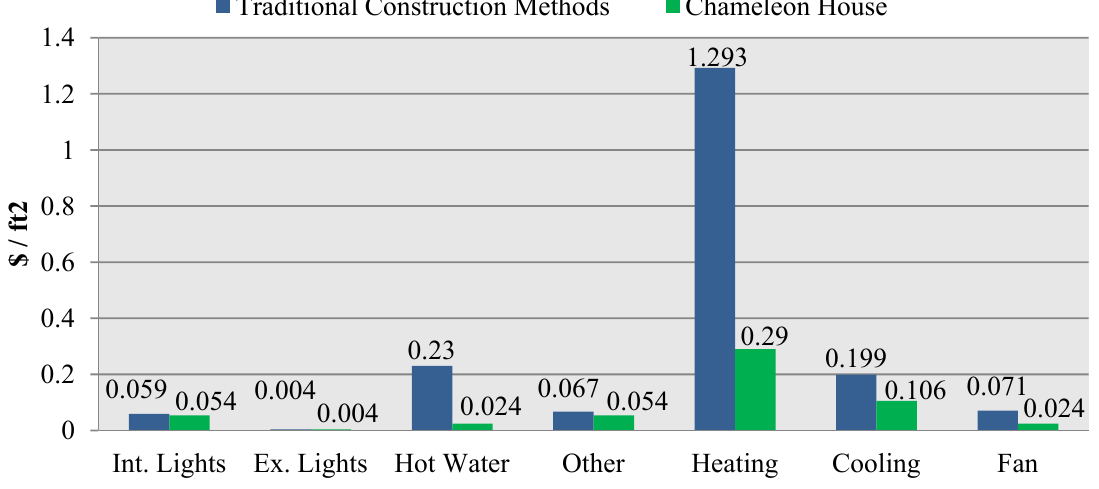
Figure 5. Annual cost breakdown—Not accounting for PV offsets.